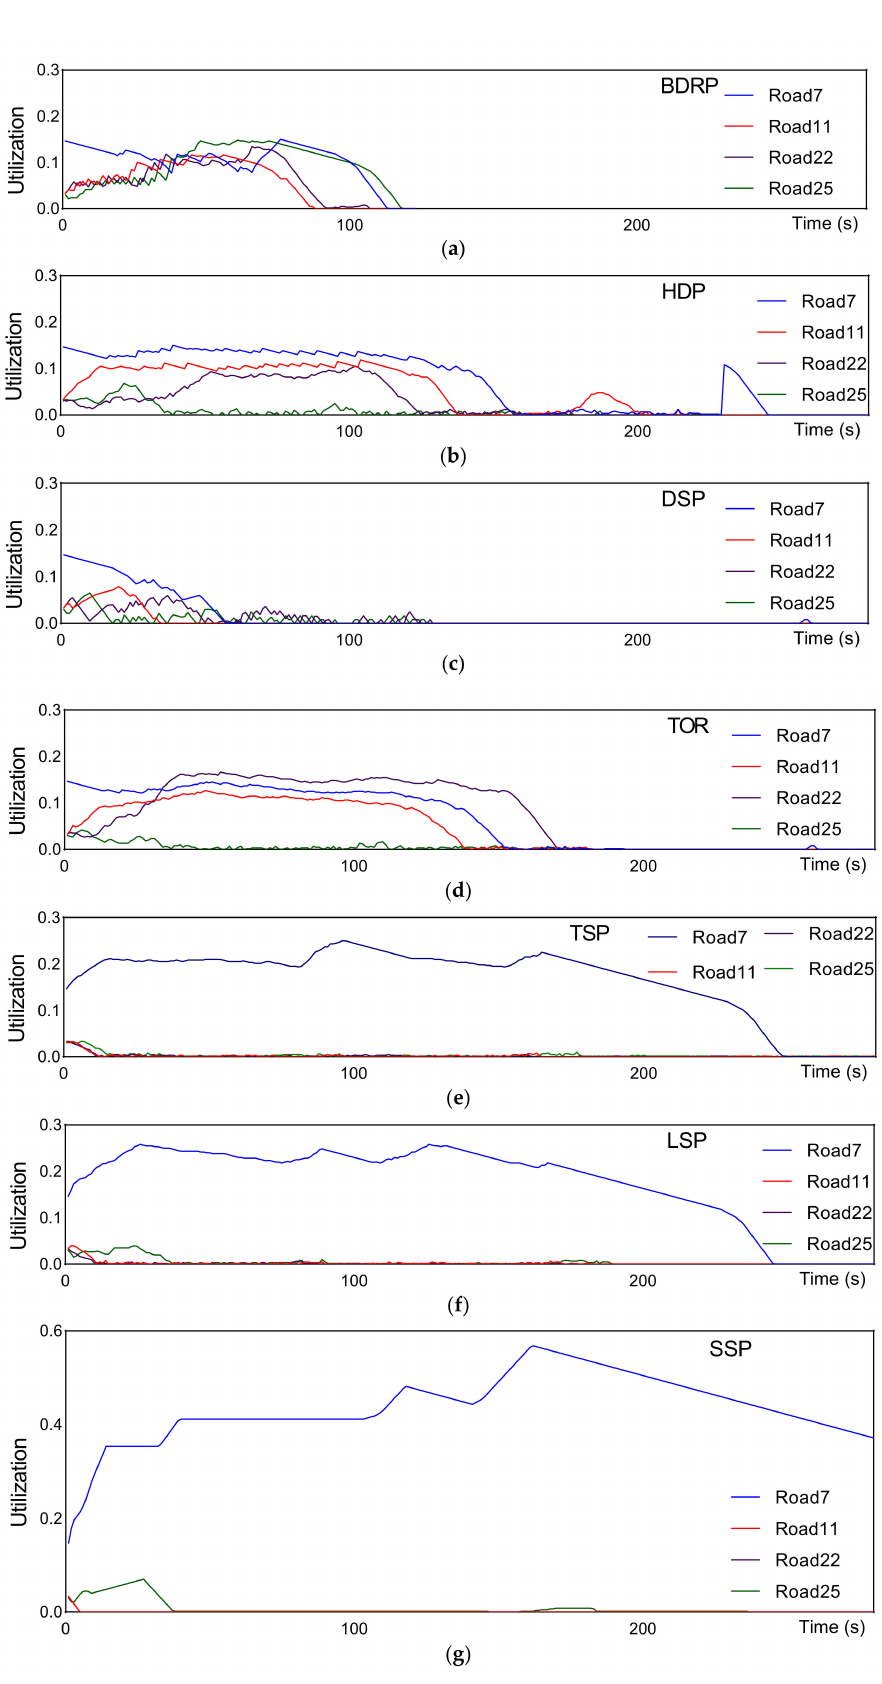
Figure 8. Road utilization rate comparison between different road-planning methods. ( a ) BDRP method; ( b ) HDP method; ( c ) DSP method; ( d ) TOR method; ( e ) TSP method; ( f ) LSP method; ( g ) SSP